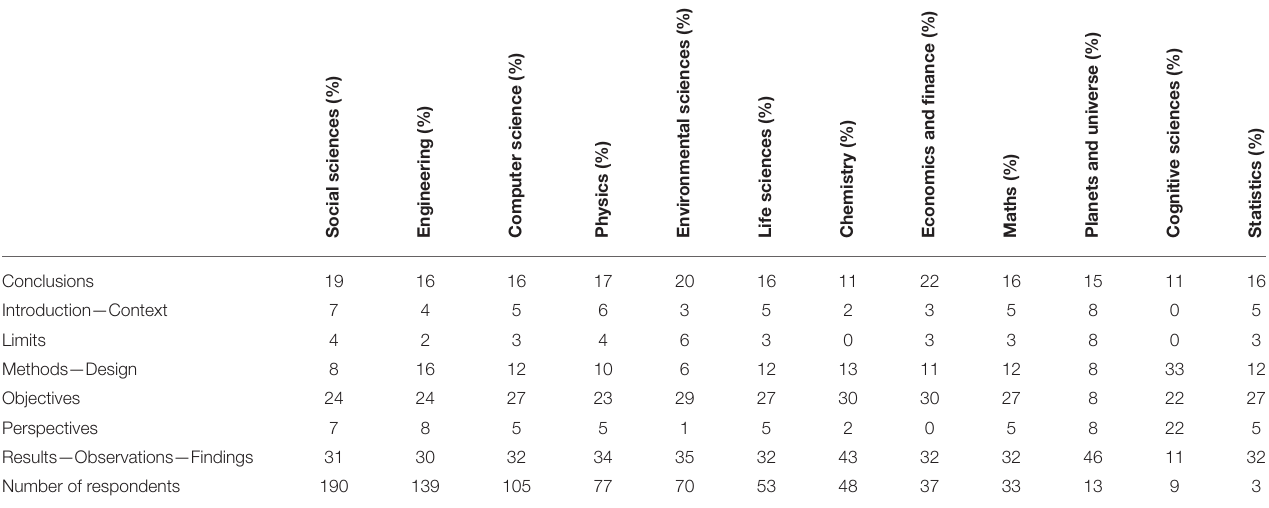
TABLE 1 | Answers distribution according to the disciplines.